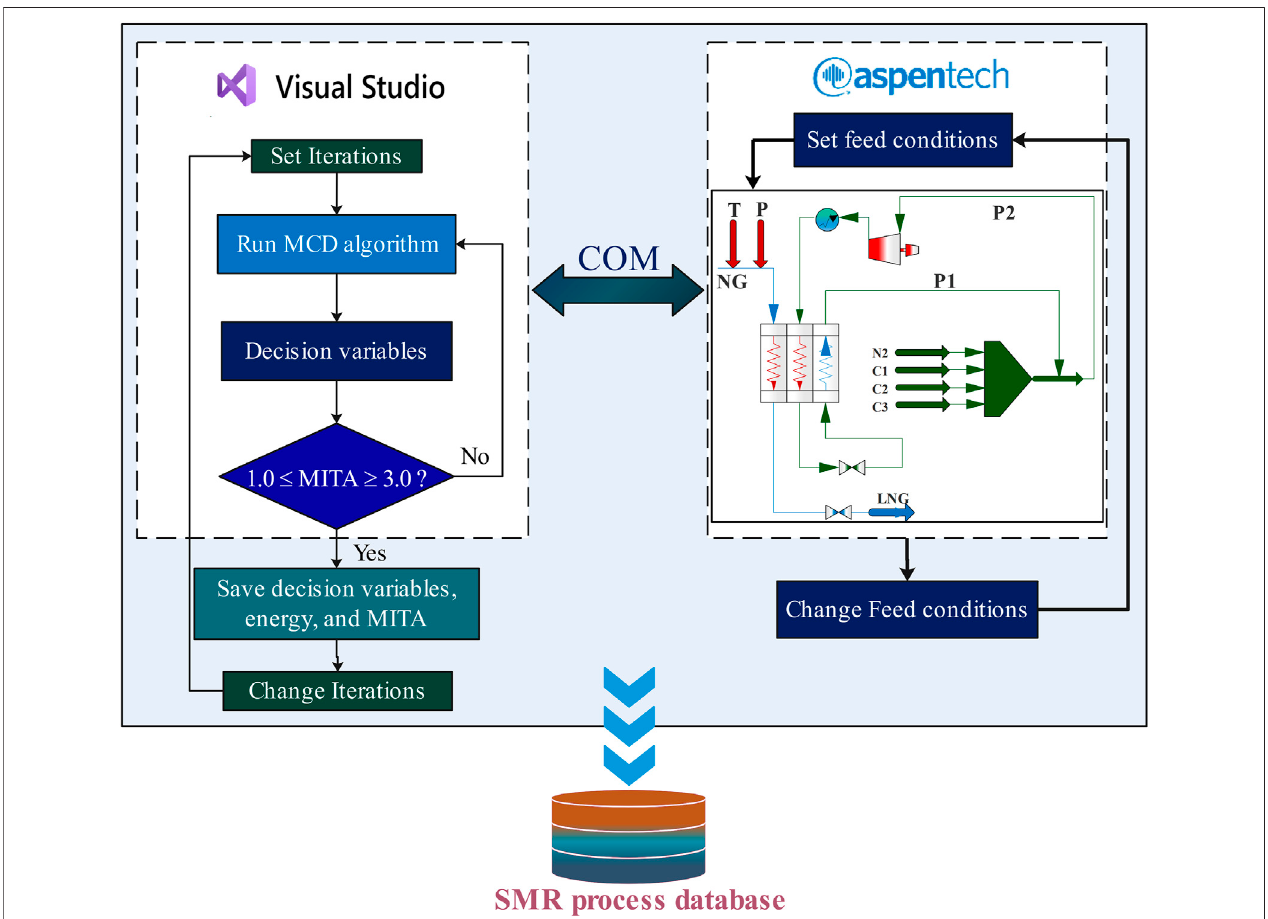
FIGURE 4 | Aspen HYSYS – Visual Studio-based data mining environment.